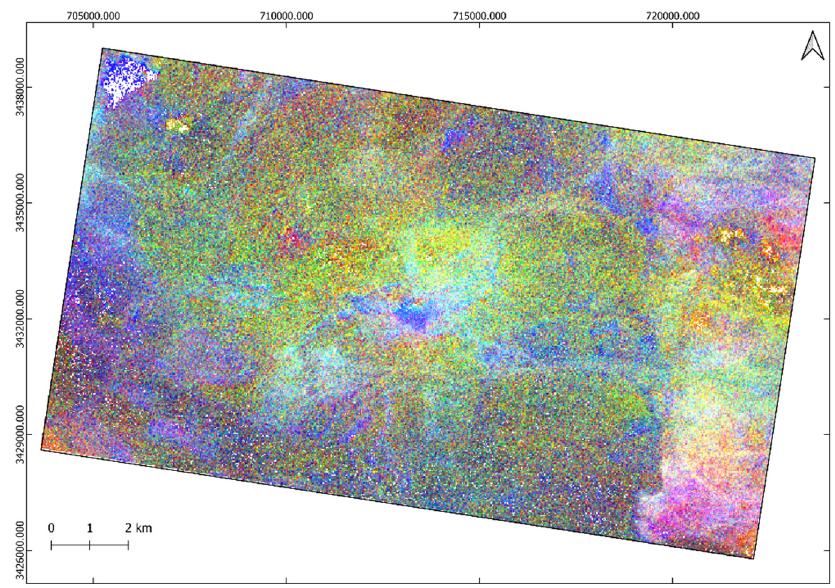
Figure 4. RGB color combination of 7/6, 5/6 and 8/9 (R: 7/6, G: 5/6, B: 8/9) image-map of the study area. study